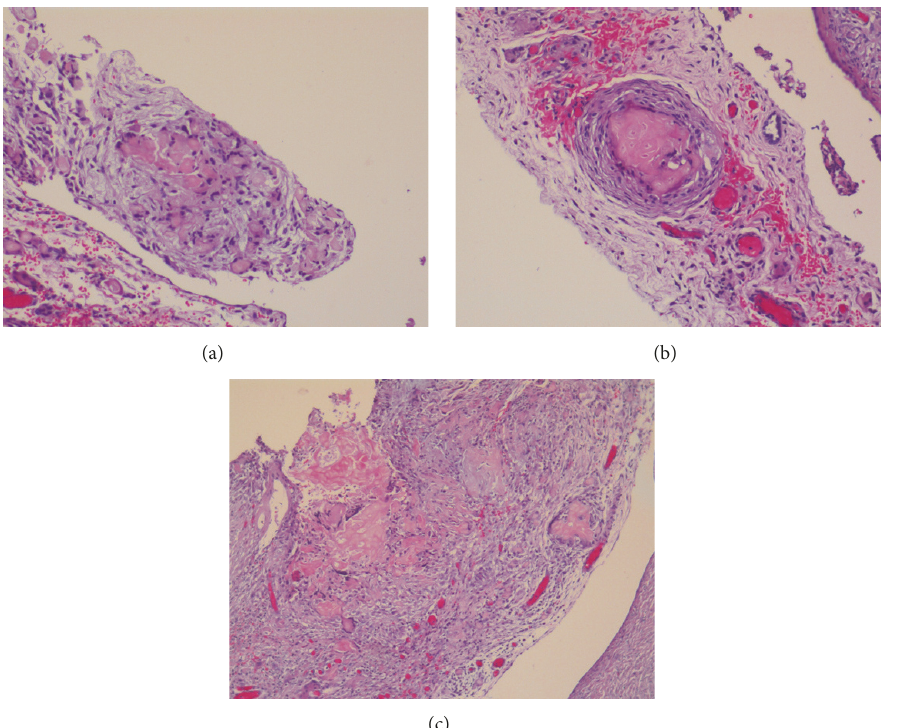
Figure 5: H&E stain: microscopic appearances of multiple keratin granulomas, composed of ghost squamous cells surrounded by foreign body giant cells, found on the serosal surface of bilateral ovaries, fallopian tubes, the appendix, and omentum.